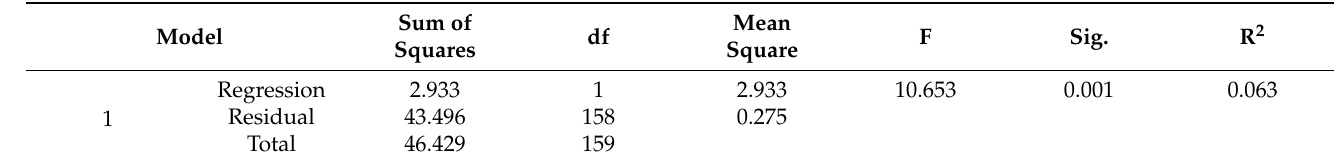
Table 3. Model summary and fit statistics of the relationship between COVID-19-related knowledge and anxiety.